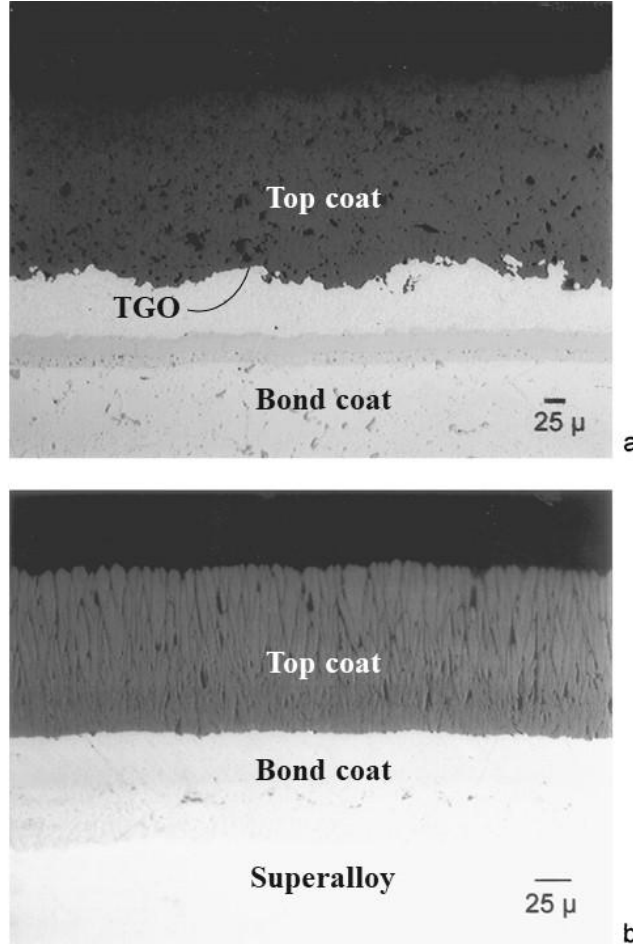
Figure 3. Photographs of ( a ) APS TBC showing a laminar morphology and ( b ) EB-PVD TBC showing a columnar morphology (Adapted from Beele et al. (1999) based on ref. [59] with the permission of Elsevier).